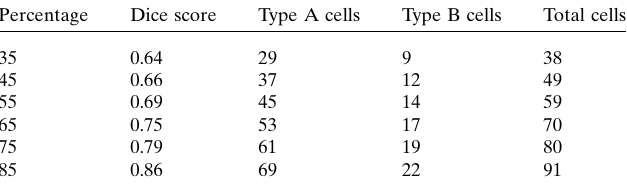
Table 2 Average dice scores from 1000 randomly sampled cases. For each case a certain percentage of cells was selected from each type of cells and clustered.